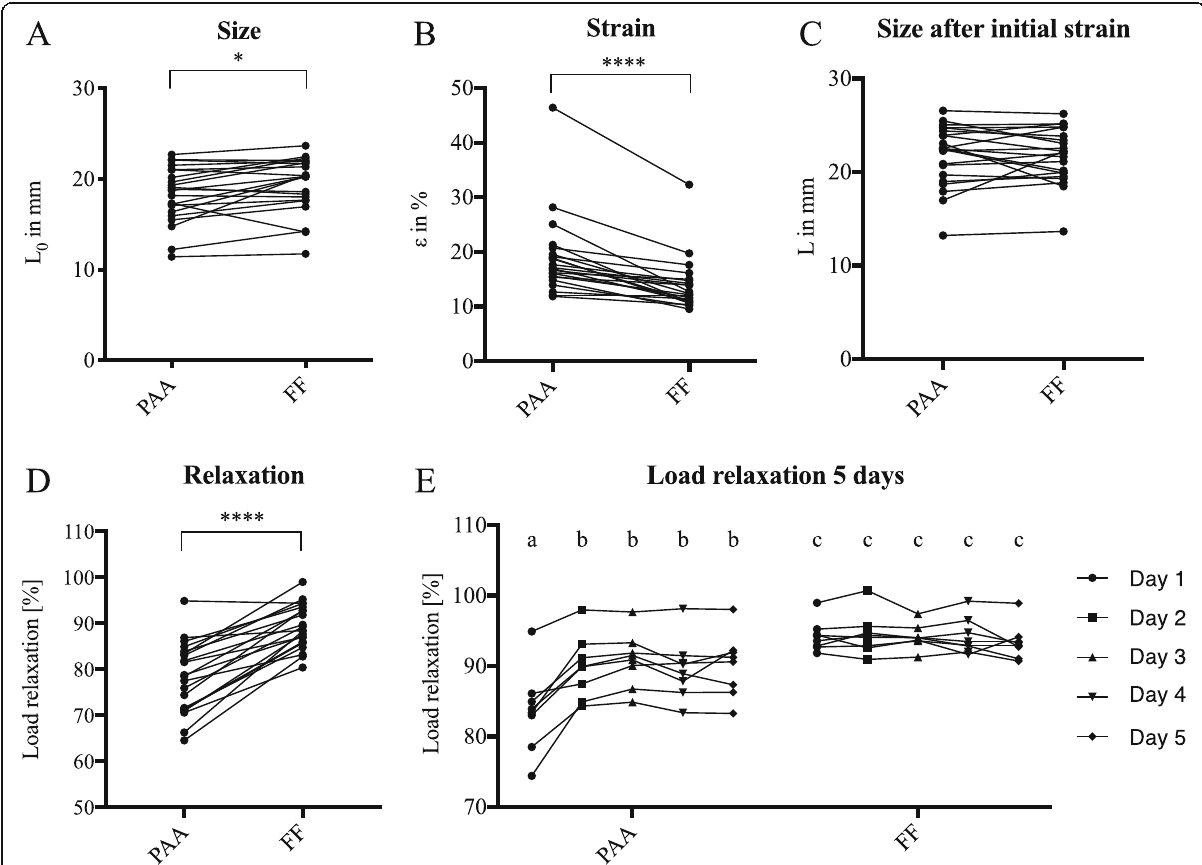
of 8 menisci this testing was performed in 5 consecutive days ( e ). Two groups sharing the same character are not significantly different ( p < 0.05)